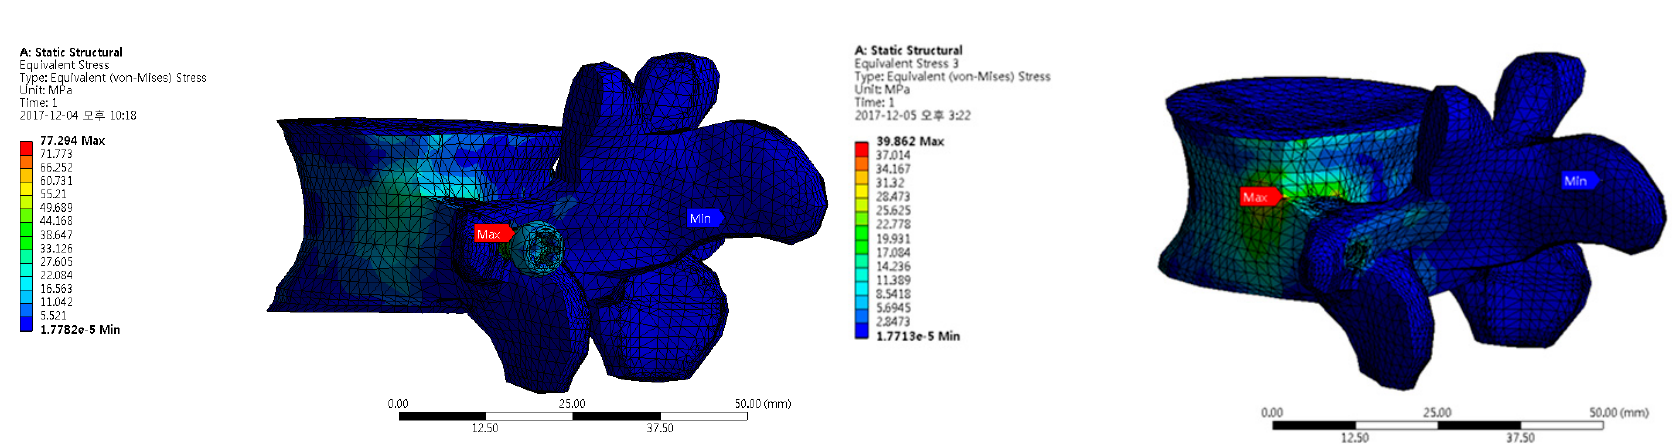
Fig. 8 Figure 8. FEA results for a single-threaded pedicle screw: Top is the pedicle screw, left is L4 and the pedicle screw, and right is